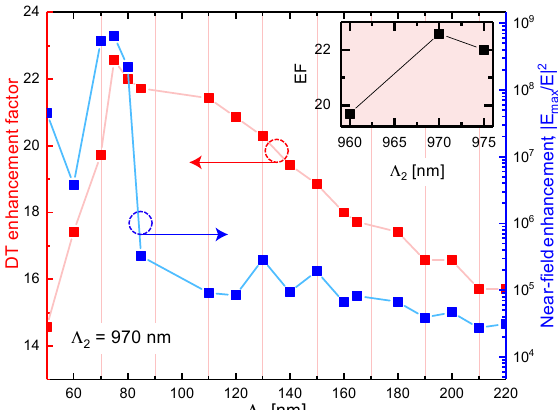
Figure 8. Variation of the local field enhancement (blue curve) and the DT enhancement factor (EF) with the lattice period Λ 1 when the other lattice period is fixed at Λ 2 = 970 nm. The inset shows EF against the lattice constant Λ 2 at fixed Λ 1 = 75 nm. Additionally, the direction and color of the horizontal arrow indicate the corresponding axis for the red and blue